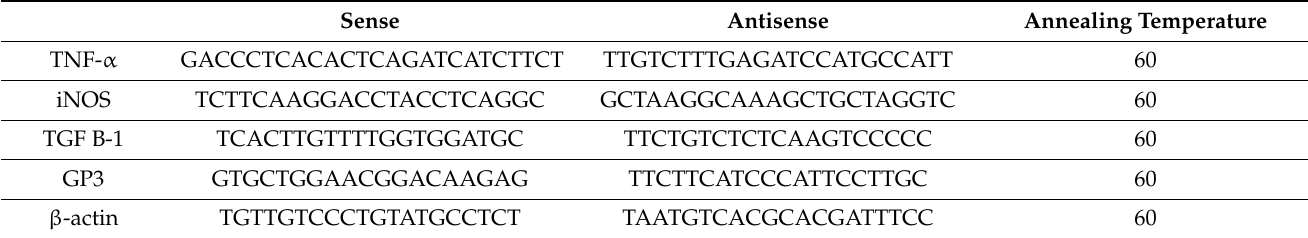
Table 1. Sequence of primers for